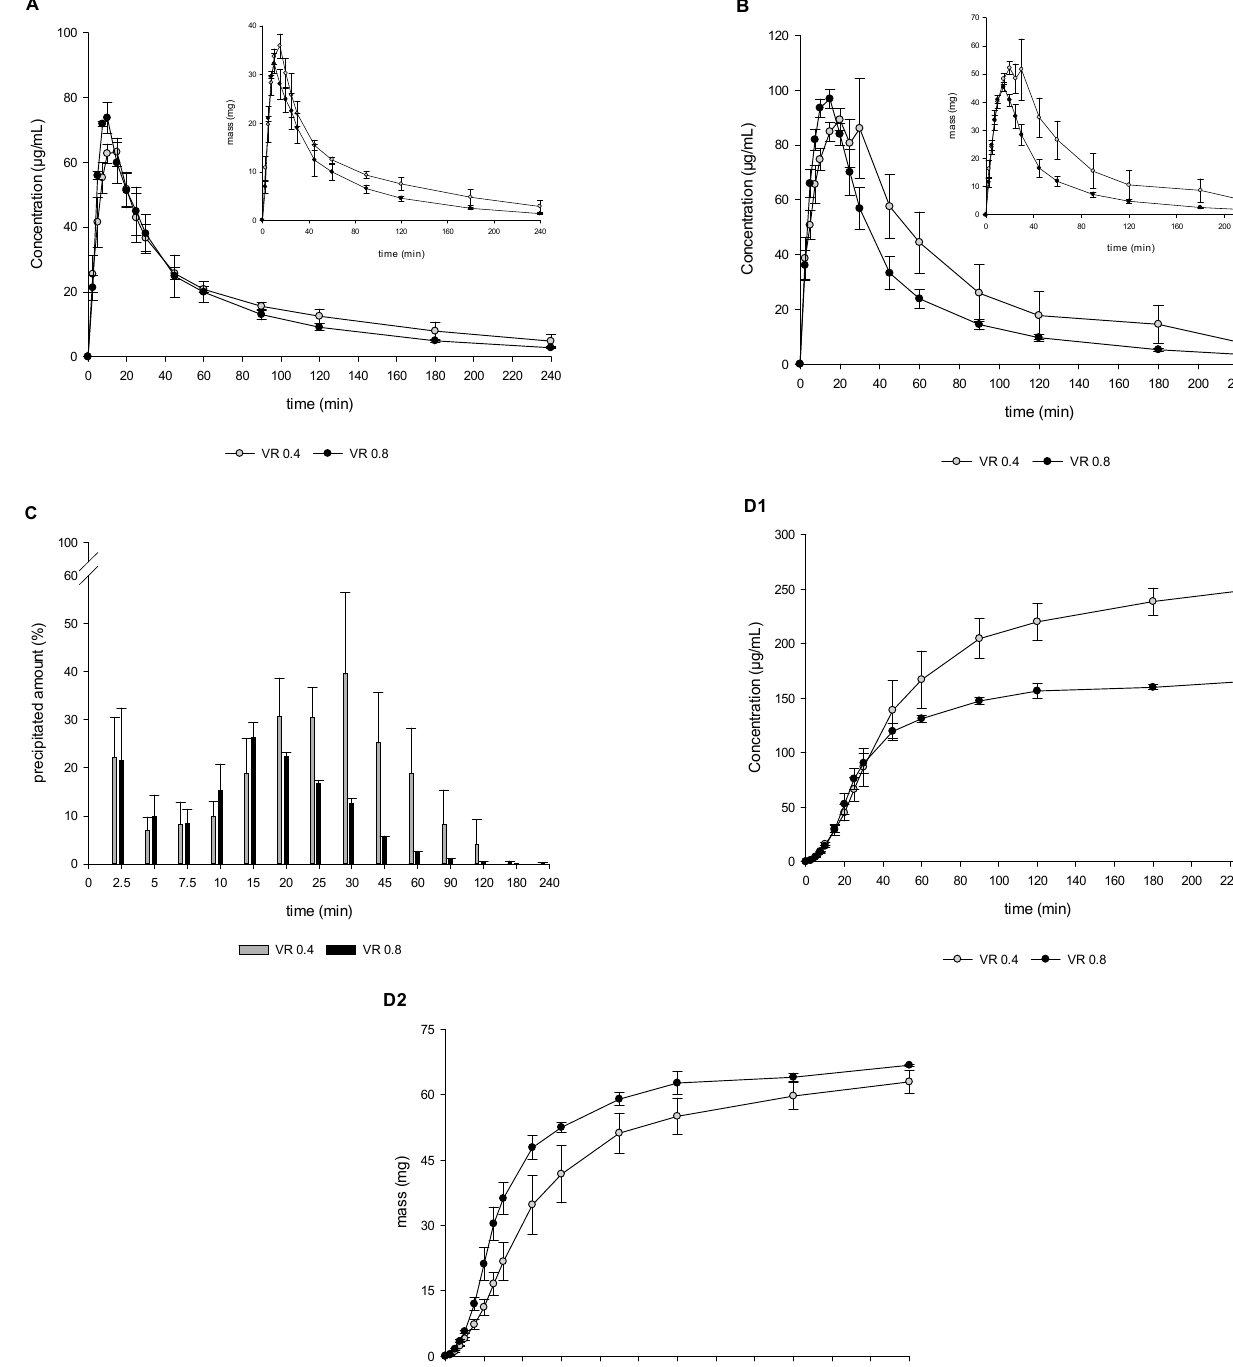
Figure 3. Drug concentration profiles (dissolved, ( A )), total amount profiles (dissolved and undissolved/precipitate, ( B )), and undissolved/precipitated amount ( C ) obtained from the aqueous filtered and un-filtered phase; partitioning profiles (( D1 ) concentration/time vs. ( D2 ) mass/time) obtained from the organic phase during in vitro DTPS experiments using VR of 0.4 vs. 0.8 and 75 mg IR tablet formulation. The precipitated mass/amount (Equations (1) and (4)) must be considered as solid mass/amount consisting of undissolved and precipitated API. Means ± SD, n = 3.